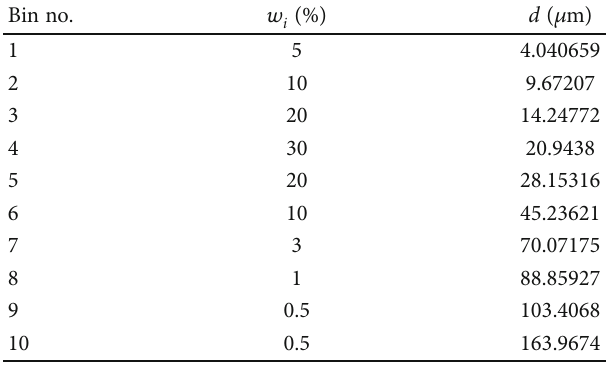
Figure 6: Collection e ffi ciency of the MS (1)-0317 airfoil for various droplet sizes at the MVD of 21 μ m in the 10-bin distribution.